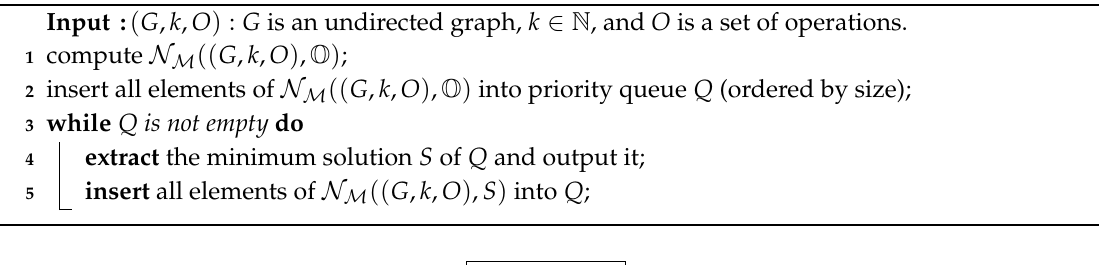
Algorithm 2: DelayFPT algorithm for E NUM - M